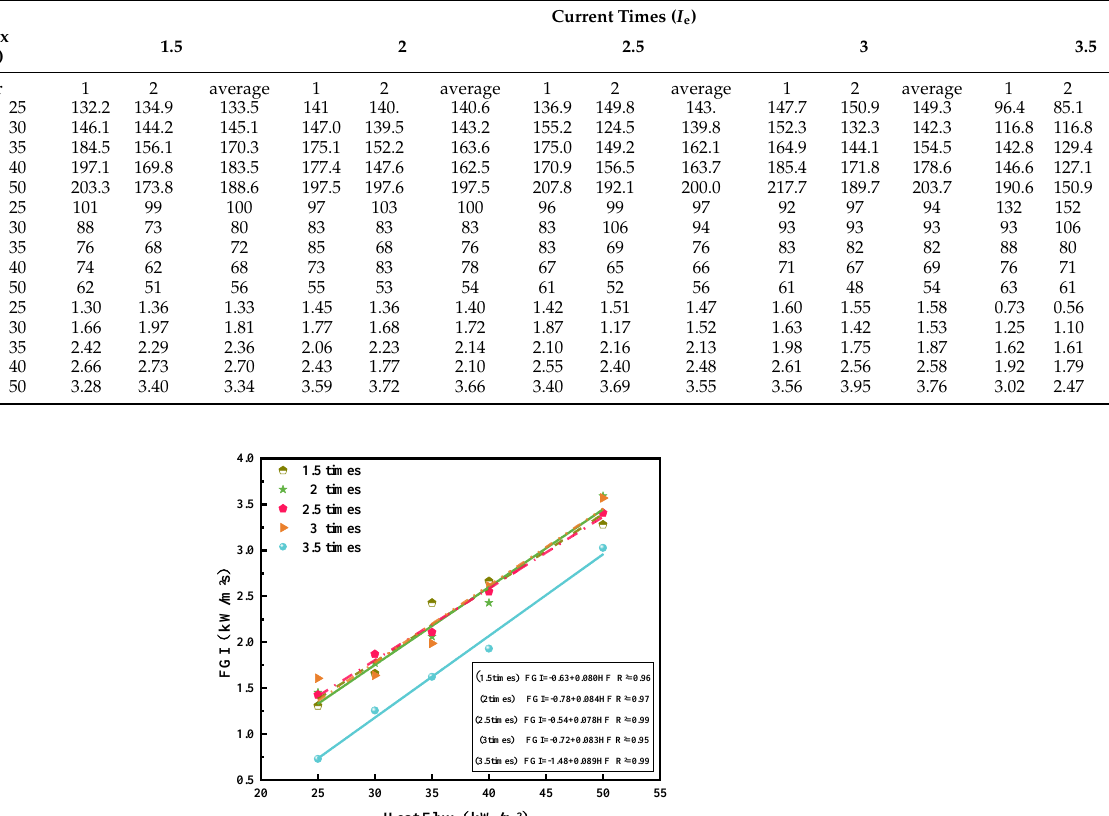
Table 3. pHRR, 𝑡 𝑝𝐻𝑅𝑅 , and FGI in two parallel tests. Table 3. pHRR, t pHRR , and FGI in two parallel tests.